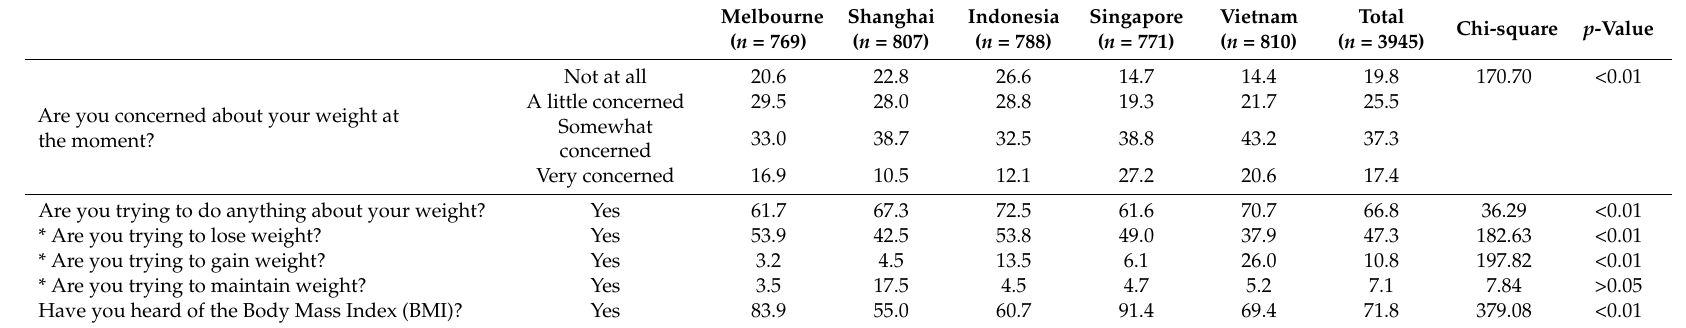
Table 2. Household food providers’ body weight concerns and weight change views and practices across study regions